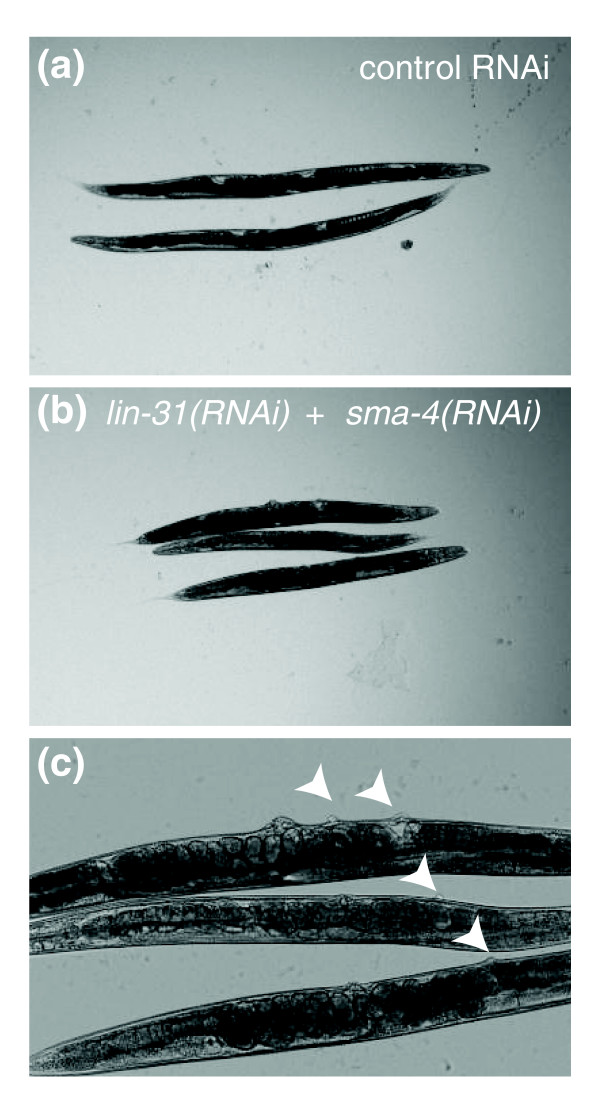
Combinatorial RNA interference (RNAi) can target two genes in the same animal. Exposing worms to a mixture of two double-stranded (ds)RNA-expressing bacterial clones, one targeting lin-31 and the other one targeting sma-4, resulted in small worms with multiple vulvae along their ventral side. Shown are RNAi-hypersensitive rrf-3 animals [19] fed on bacteria expressing (a) a nontargeting dsRNA (control) and (b) combined bacterial clones expressing dsRNA against lin-31 and sma-4 (magnified in (c)). Pseudovulvae are indicated by white arrowheads.